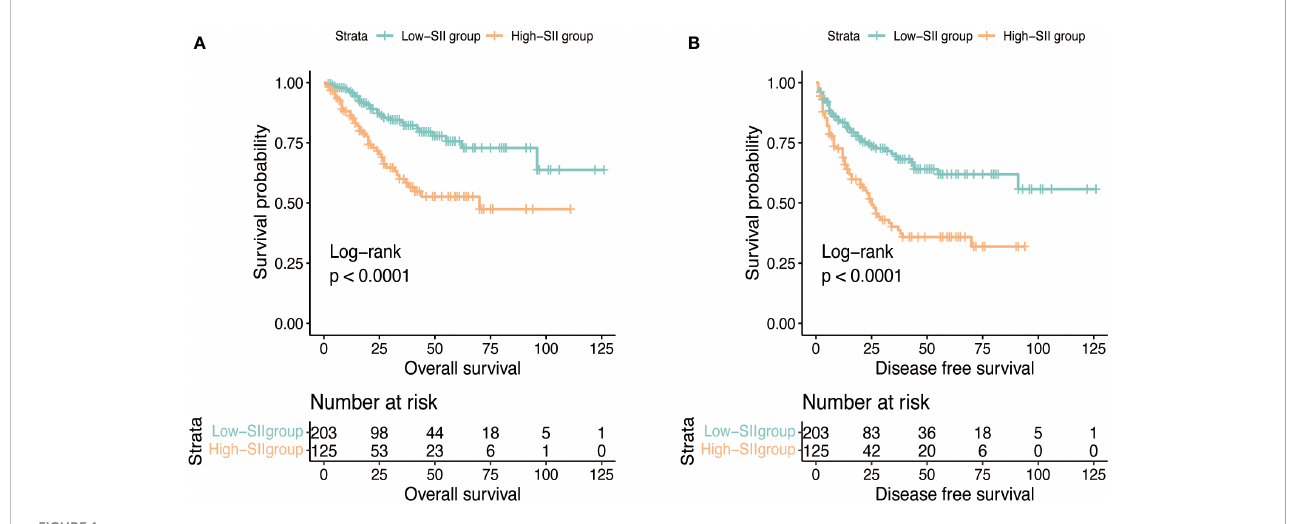
FIGURE 1 Kaplan-Meier curves for OS (A) and DFS (B) strati fi ed by